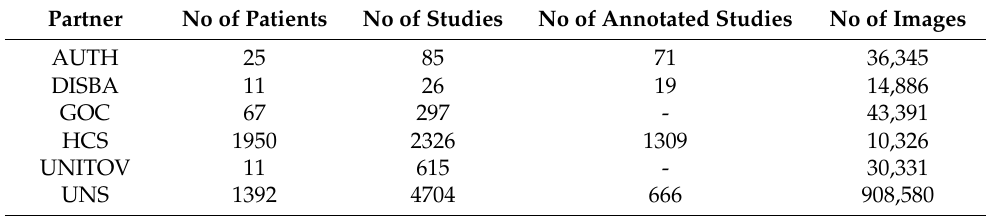
Table 2. Current data storage